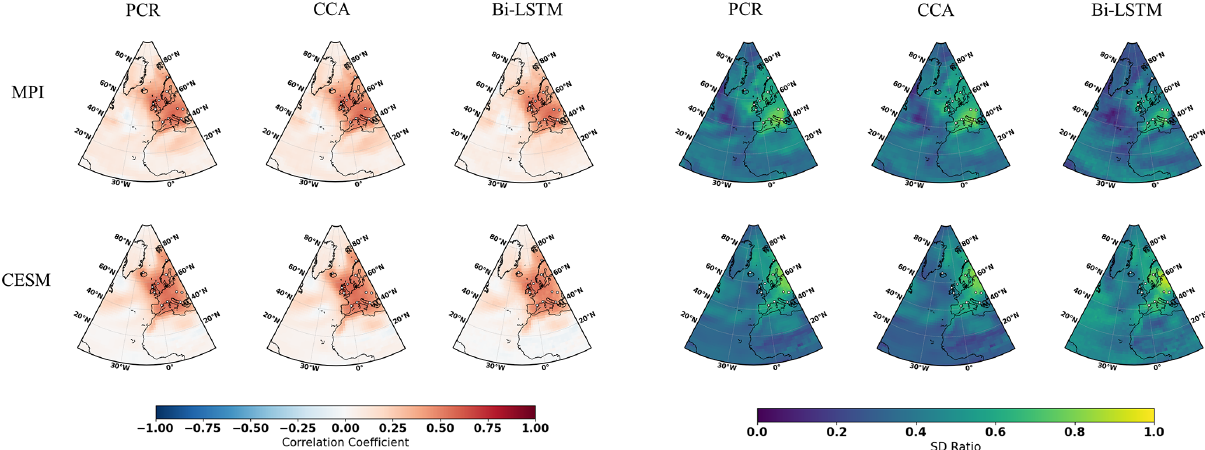
Figure 3. The same as Fig. 2 but for employing the full 11-pseudoproxy network with white noise